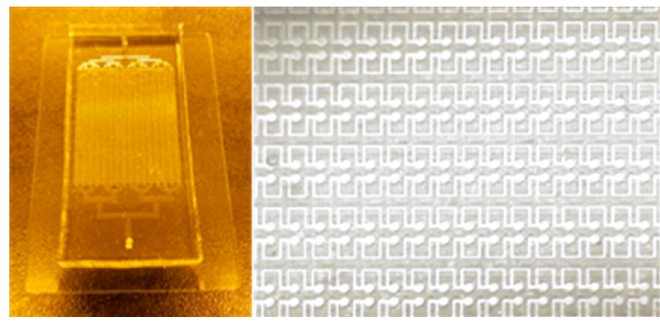
Figure 2. Optical images of fabricated parallel microfluidic device.